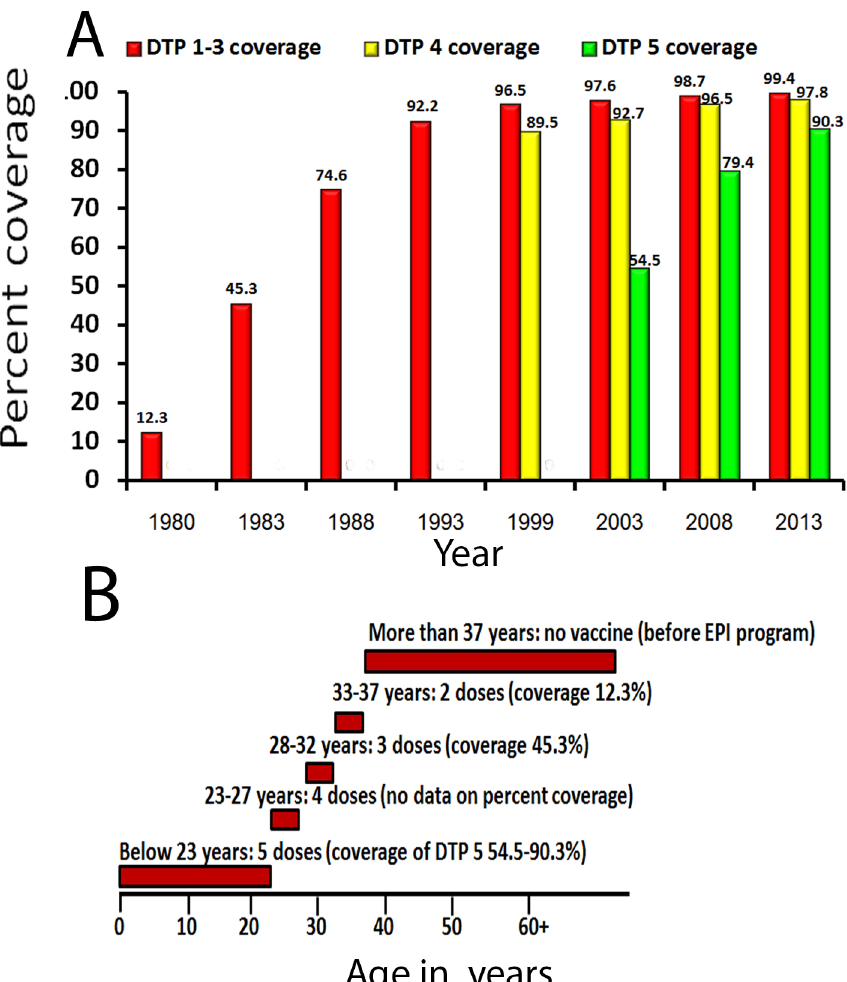
Fig 2. Coverage of diphtheria – tetanus and whole cell pertussis (DTP) vaccine in Thailand, 1980 – 2013. (A) Increasing vaccine coverage beginning in 1980. The red bar represented vaccination coverage for 3 completed doses (DTP 1 – 3) when administered to infants at 2, 4 and 6 months of age. The yellow bar represented coverage for 4 completed doses (DTP 4), which included an additional dose at 18 months. The green bar represented coverage for 5 completed doses (DTP 5), which included a fifth dose at 48 months. (B) The age at which individuals received the pertussis vaccine according to the Expanded Program of Immunization in Thailand. Data on percent coverage were summarized in